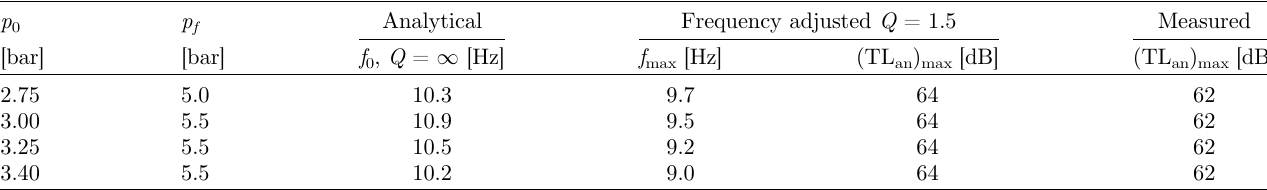
Table 2. Comparison of resonance frequencies f 0 , (TL an ) max and corresponding f max for analytical undamped ( Q = 1 ), frequency adjusted undamped ( Q = 1 ) and frequency adjusted damped ( Q = 1.5) from measurements. p p 0